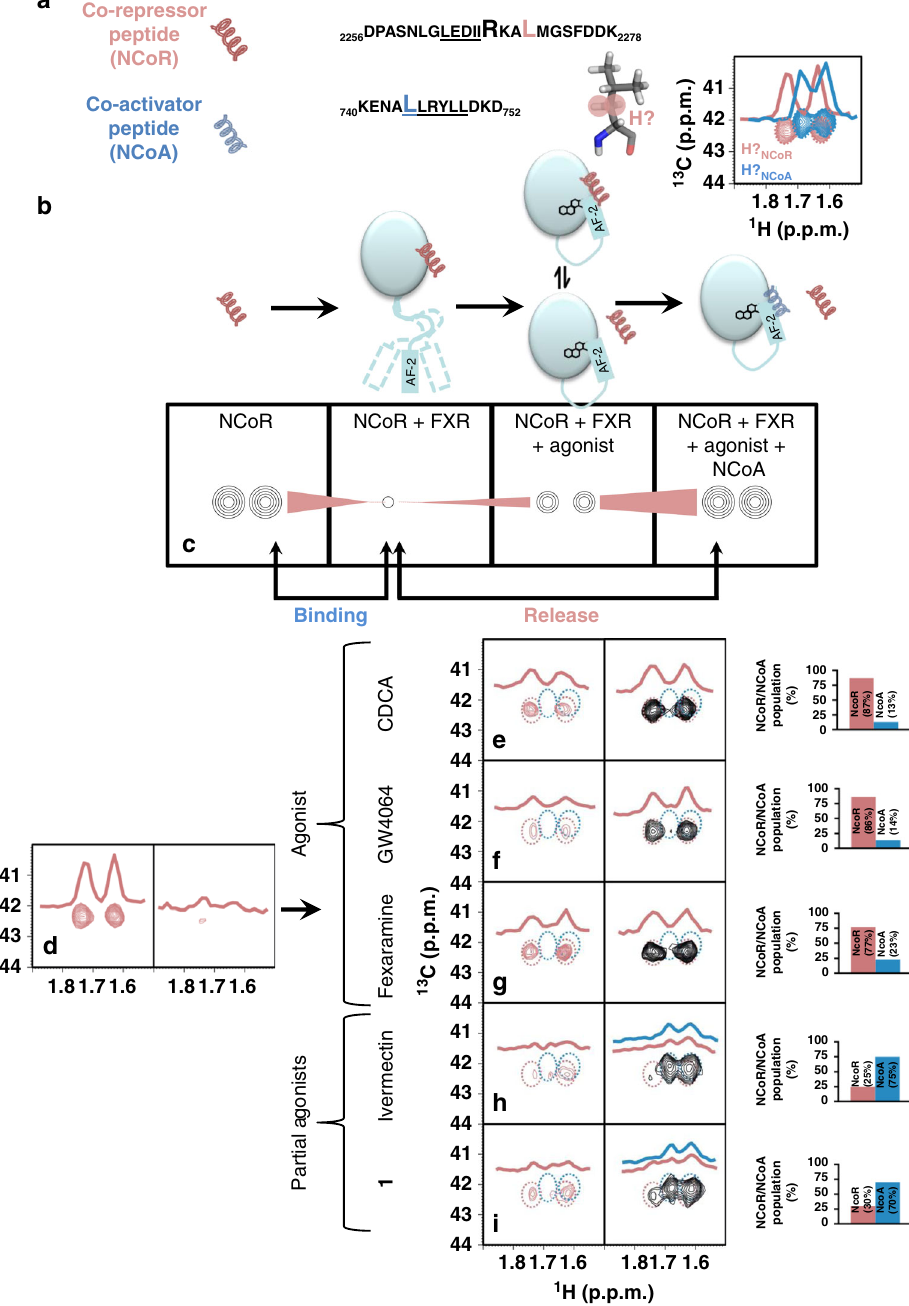
Fig. 5 NMR studies on the FXR activation mechanism. a Amino acid sequence of co-repressor (NCoR) and the co-activator (NCoA) with 15 N/ 13 C-isotpically enriched amino acids highlighted with larger font. A stick model of leucine with its H β highlighted. The inset shows the H β -region of 1 H, 13 C-HSQC spectra of the labelled peptides. The chemical shifts for the NCoA and NCoR are not overlapping and are easily distinguishable. b Schematic representation of the typical behaviour of an LBD in response to ligand-dependent activation and c resulting changes in the NMR signal (H β of leucine) of the co-repressor (NCoR) at different points of interaction. Disappearance of NMR signals upon binding to FXR, partial reappearing (release) upon addition of agonist and further reappearance upon addition of NCoA indicating complete release of NCoR. d Monitoring of the H β -signal of leucine in NCoR in response to addition of FXR, followed by addition of ligand ( e – i ) and the co-activator peptide: The H β signals of the co-repressor ( d ) are severely broadened upon addition of FXR, indicating binding. Upon addition of an agonists ( e – g ), an increase in signal intensity is observed indicating that agonist binding induces partial release of NCoR ( e – g , left spectra). Further, upon addition of the co-activator peptide, the intensity of the NCoR signals further increases and the signals of NCoA disappear (blue circled region), indicating the complete release of the co-repressor and binding of NCoA to the FXR-agonist complex ( e – g , right spectrum). The bar graphs adjacent to the spectra represent the relative populations of the released NCoR/NCoA peptides upon binding of the ligand. Populations of each reporter signal were determined from their intensities as P[(CDCA NCoR ) = 100 ∙ I NCoR /(I NCoR + I NCoR )] and vice versa. The spectra obtained in the presence of partial agonists ( h , i ) show marginal increase in the intensity of the repressor signals and minor line broadening for the signals of the activator, indicating that both co-repressor and the co-activator bind. This is also re fl ected by the relative populations of the released NCoR/NCoA peptides. Antagonist guggulsterone, in contrast, in this setting induces full binding of NCoR peptide with no recruitment of NCoA peptide (see Supplementary Fig.